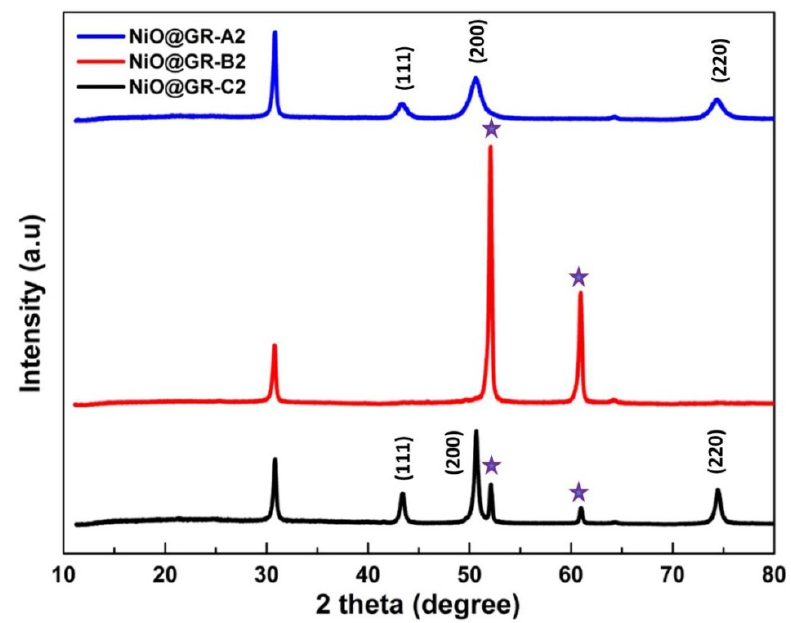
Figure 1. XRD patterns for NiO x @GR-A2, NiO x @GR-B2, and NiO x @GR-C2.